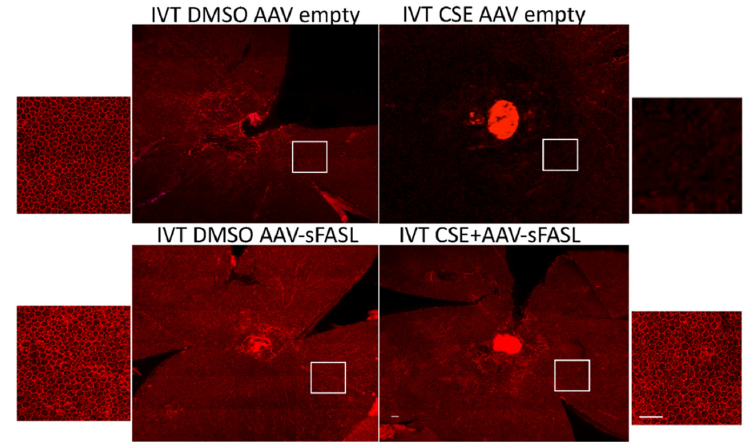
Figure 7. Fas inhibitor gene therapy AAV2-sFasL protects RPE from cigarette smoke extract-induced damage. Wild-type mice ( n = 5 per group) were given IVT AAV2-sFasL or IVT AAV2-empty vector in each eye. Two weeks later, mice were given IVT CSE in one eye or DMSO vehicle in the contralateral eye. After 10 days, RPE flatmounts were immunolabeled with anti-ZO-1. The RPE lost its hexagonal shape after CSE injection. This damage was mitigated by AAV2-sFasL treatment. White boxes highlight the location of the magnified images of the RPE. Bar = 50 µm.